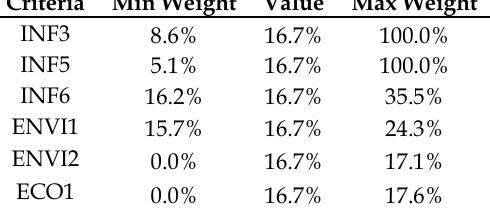
Table 8. Stability intervals for the first ranked alternative